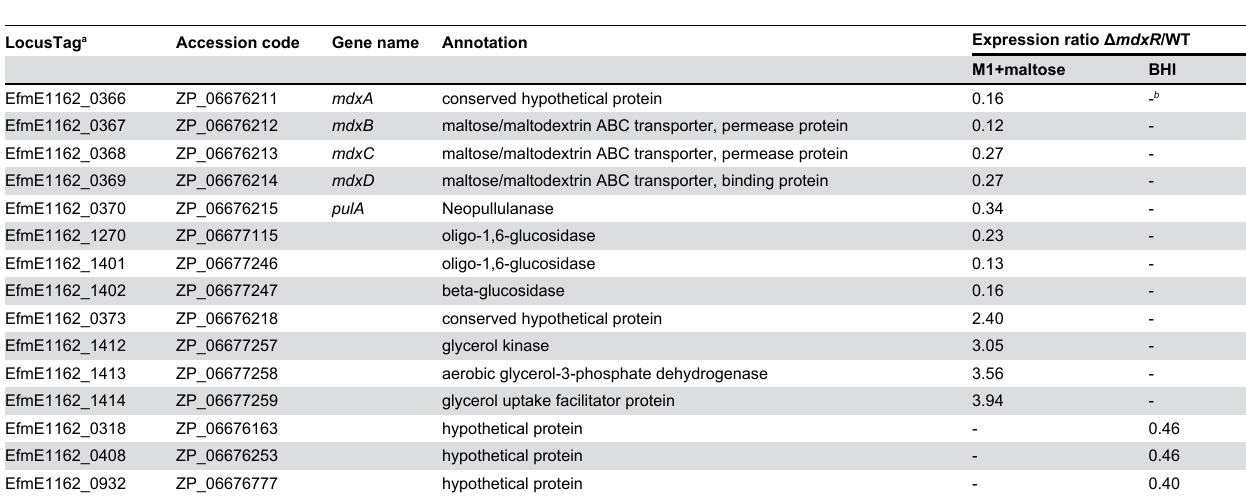
Table 3. Comparative transcriptome analysis of E. faecium E1162 and the Δ mdxR mutant during mid-exponential growth in M1+maltose and BHI.